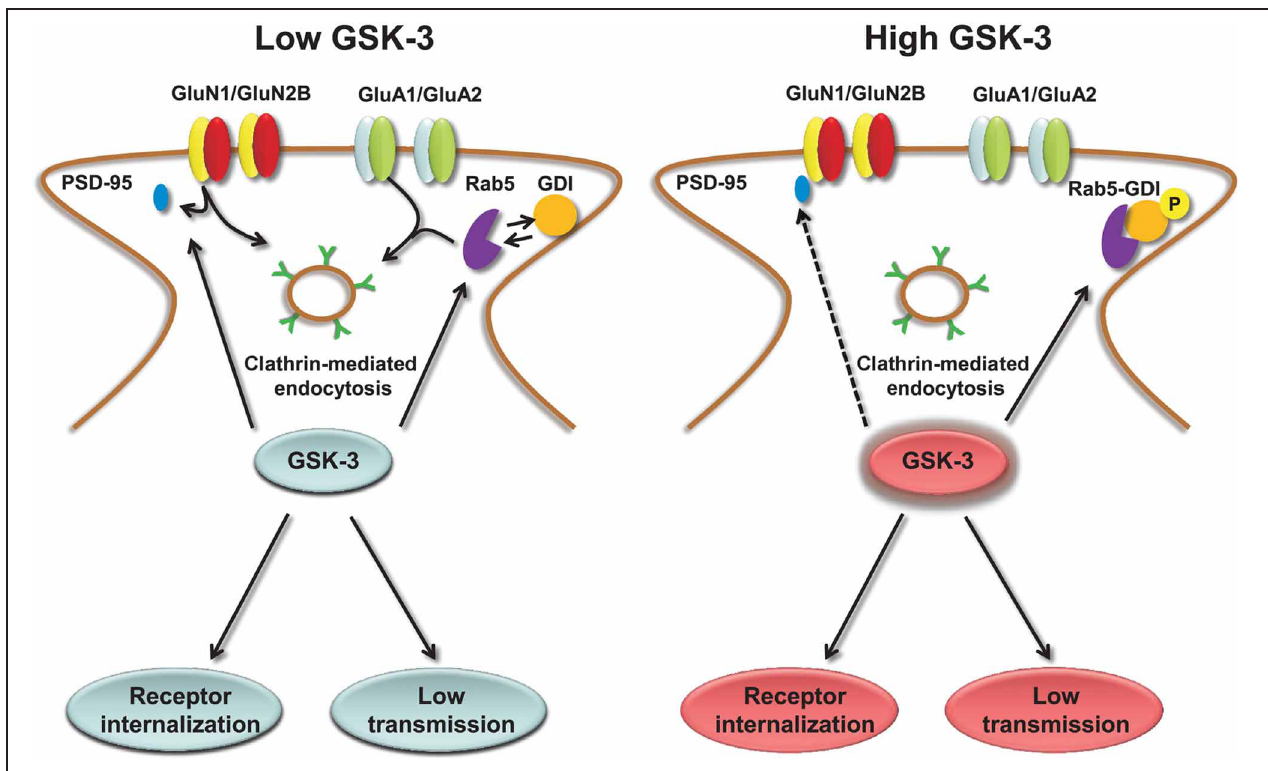
GSK-3-dependent NMDA receptor internalization is limited to GluN2B containing receptors and requires dissociation of PSD-95 from the GluN2B C-terminal tail through a series of steps that are induced by GSK-3 inhibitors. Conversely, under high levels of GSK-3, AMPA and NMDA receptors are highly expressed at the plasma membrane, and receptor internalization is